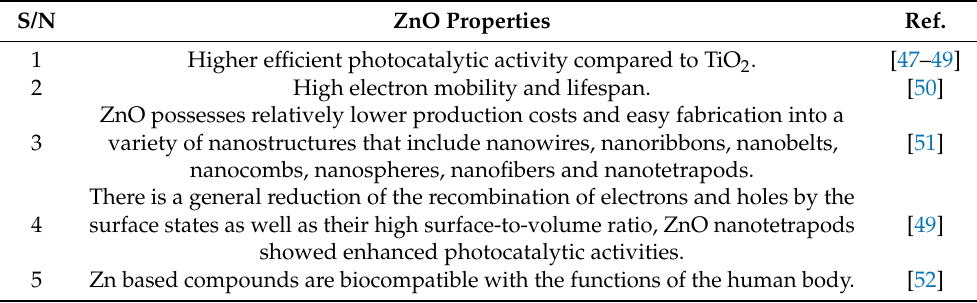
Table 2. Desirable properties of ZnO in heterogeneous catalysis. S/N ZnO Properties